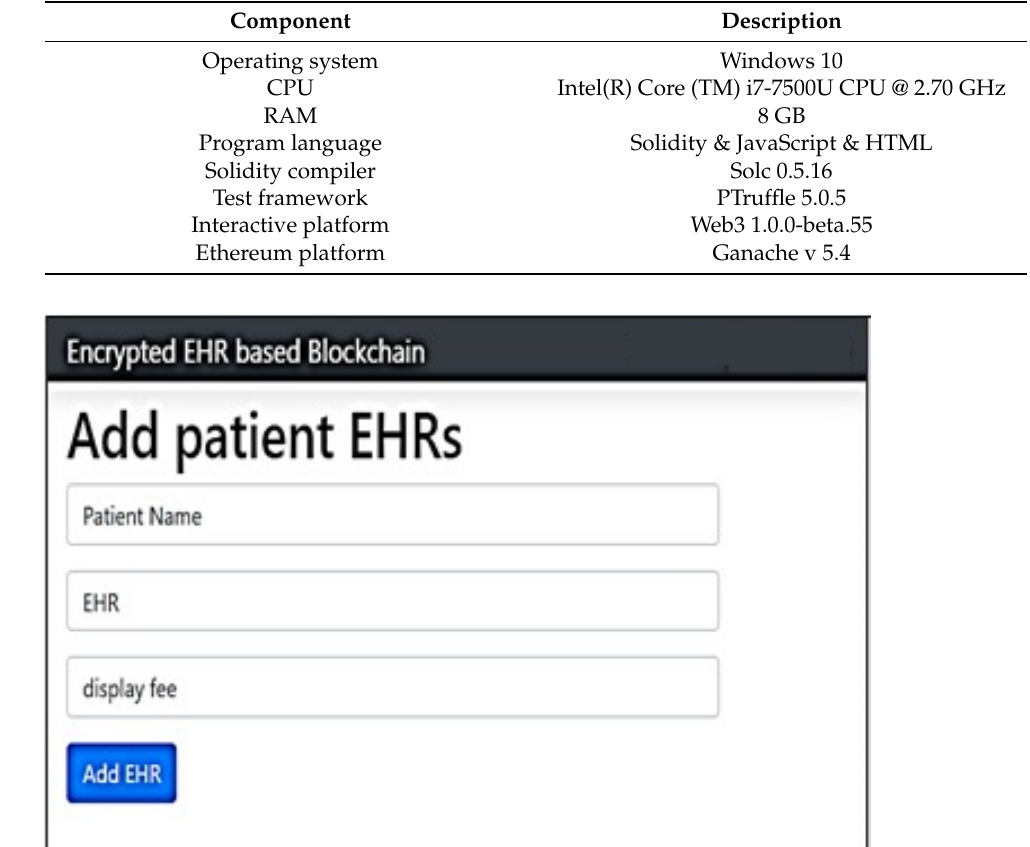
Table 3. Configurations of Ethereum test blockchain.